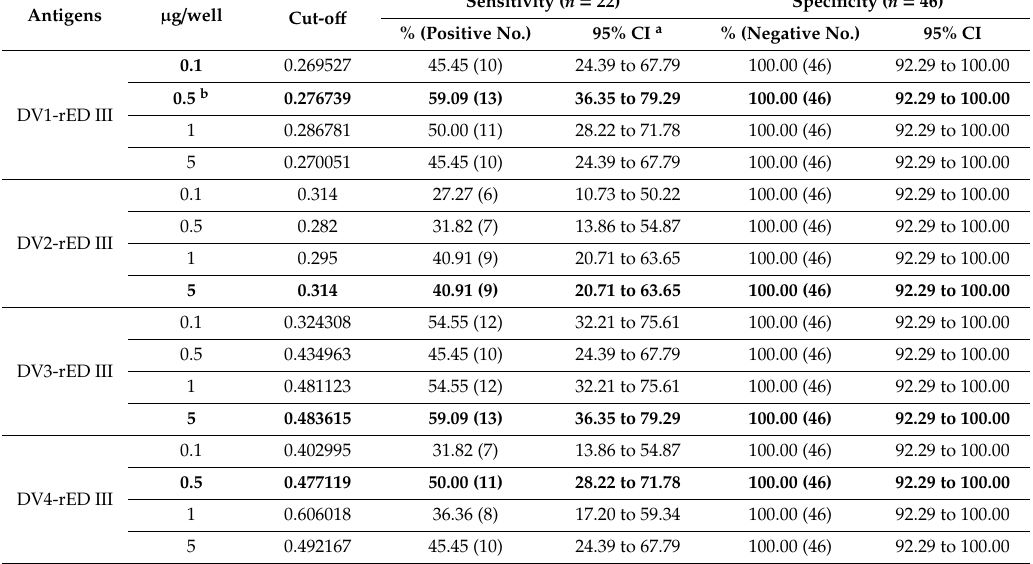
Figure 5. Recombinant antigen-linked ELISA with patient specimens. Table 2. Sensitivity and specificity of each antigen-linked ELISA.